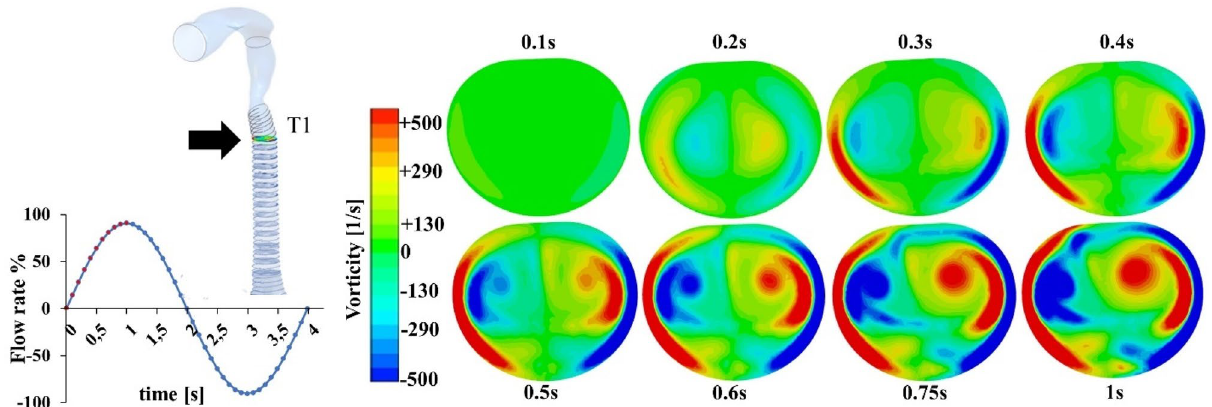
Figure 3. In evidence the asymmetrical development of the vorticity field at cross section T1, reaching the maximum at the end of the ascendant part of the inhalation cycle (0–1 s). (Fluent v16, CFD-Post v16-Ansys, www.ansys